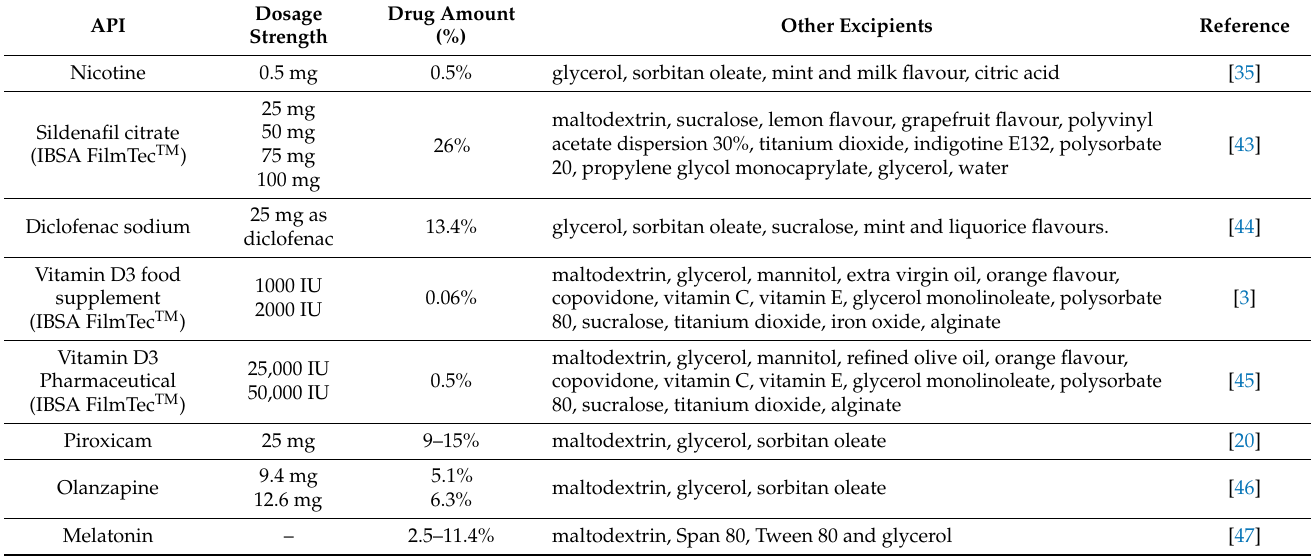
Table 4. Example of proposed ODF based on maltodextrin as the film-forming